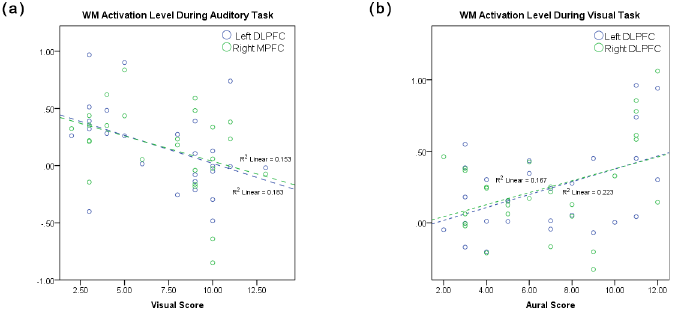
Fig 5. Significant correlation between VARK score and level of activation. (a) in left DLPFC VARK visual score was correlated with level of activation during performance of auditory task while (b) VARK aural score was correlated with level of activation in left and right DLPFC during performance of visual